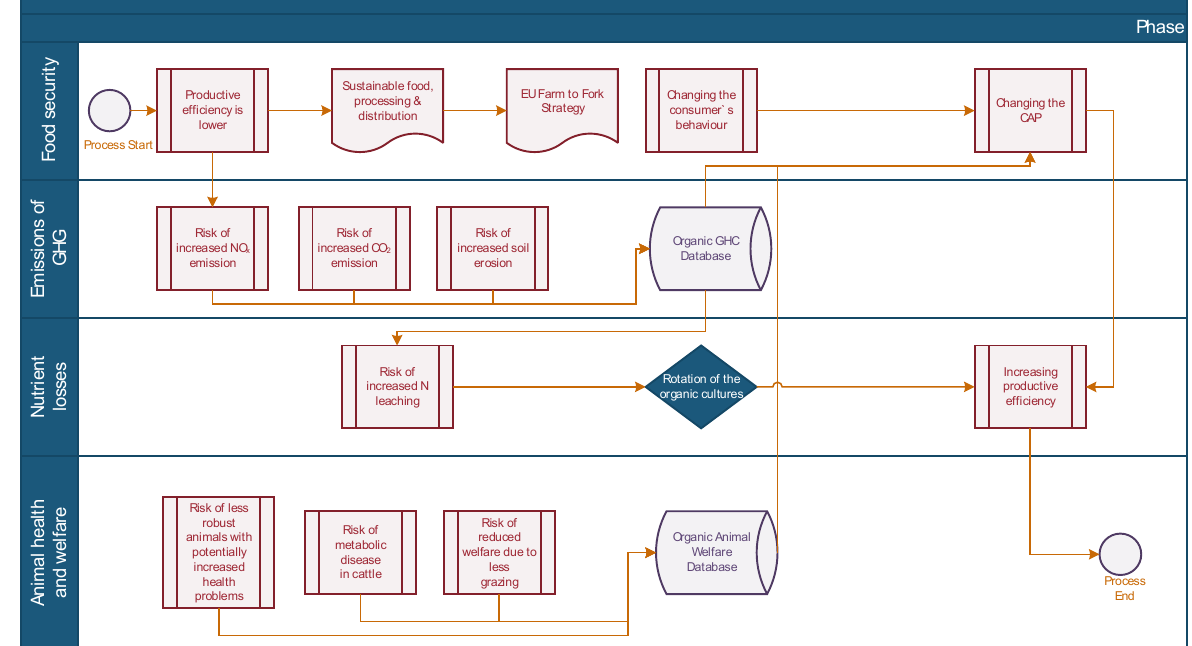
Figure 7. The risks and opportunities offered by organic farming in the context of the Green Deal and CAP. Source: Elaborated by the authors.